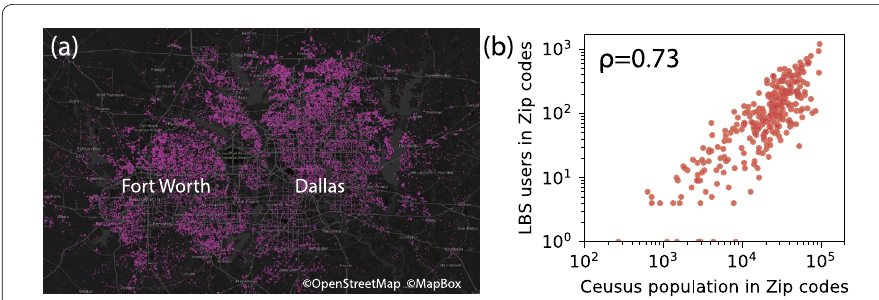
population from the census